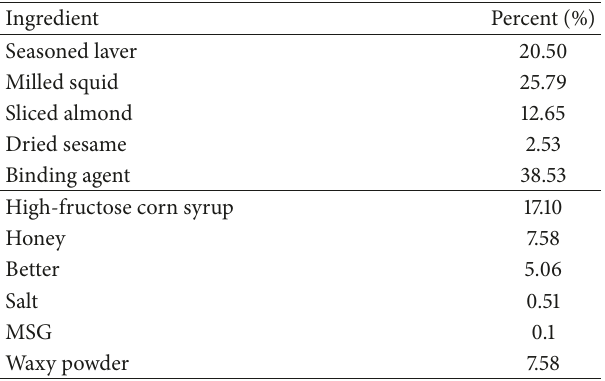
Table 1: Formulation of squid-laver snack (SLS).